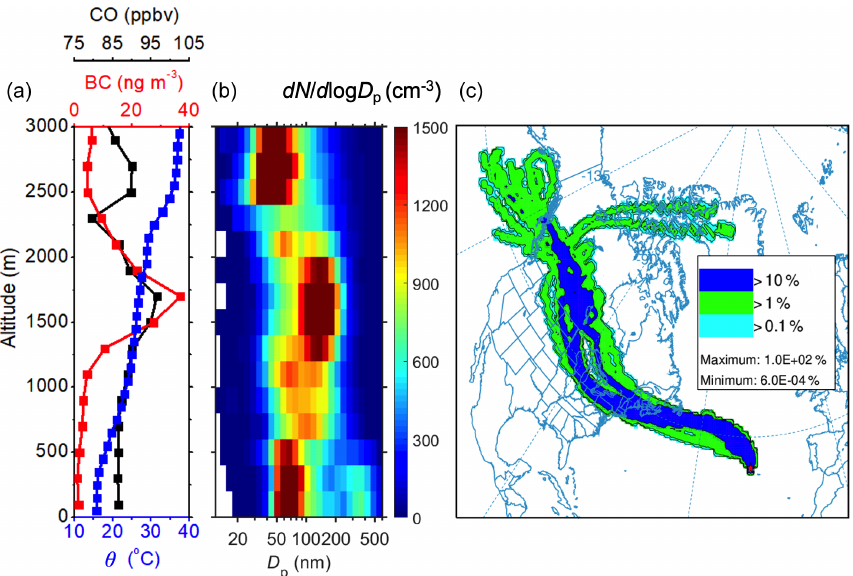
Figure 8. A long-range transport event observed during the research flight on 29 June 2017. (a) Vertical profiles of potential temperature ( θ ), black carbon (BC) mass concentration, and carbon monoxide (CO) mixing ratio. (b) Vertical contour of aerosol size distributions as a function of altitude measured by the FIMS. (c) Frequency analysis of hourly back trajectories arriving at the ENA site on 29 June 2017 generated by HYSPLIT. The frequency is the sum of the number of trajectories that passed through each grid cell divided by the total number of trajectories analyzed. The CO mixing ratio, BC concentration, and size distributions are normalized to standard temperature and pressure (273.15K and 101.325kPa;